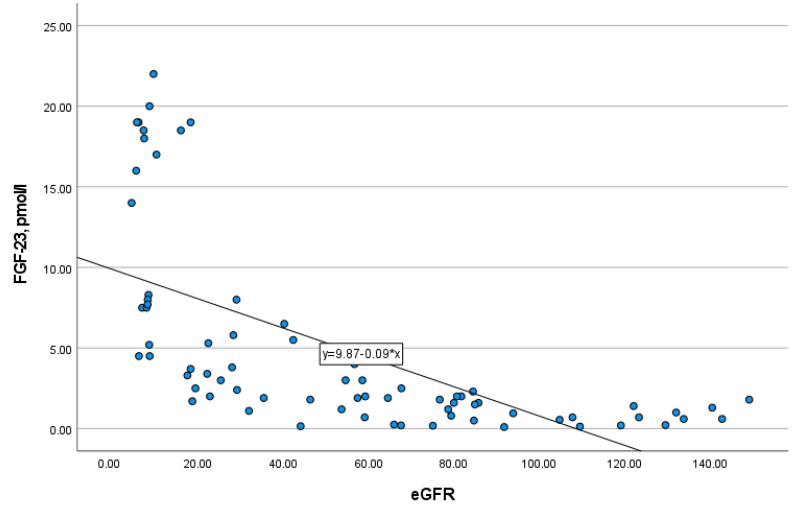
Figure 2. The correlation of FGF-23 with eGFR ( r = − 0.851, p = 0.000).